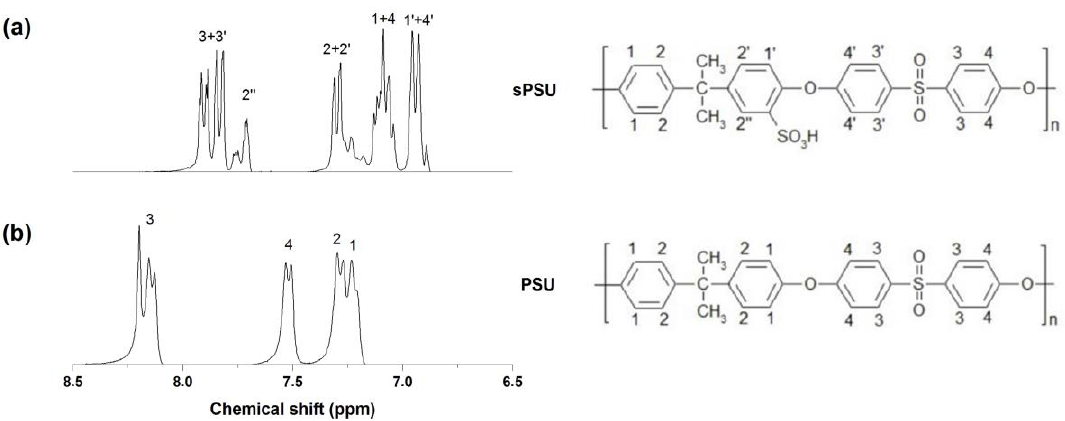
Figure 1. 1 H-NMR spectra of ( a ) sulfonated polysulfone (sPSU) and ( b ) polysulfone (PSU).